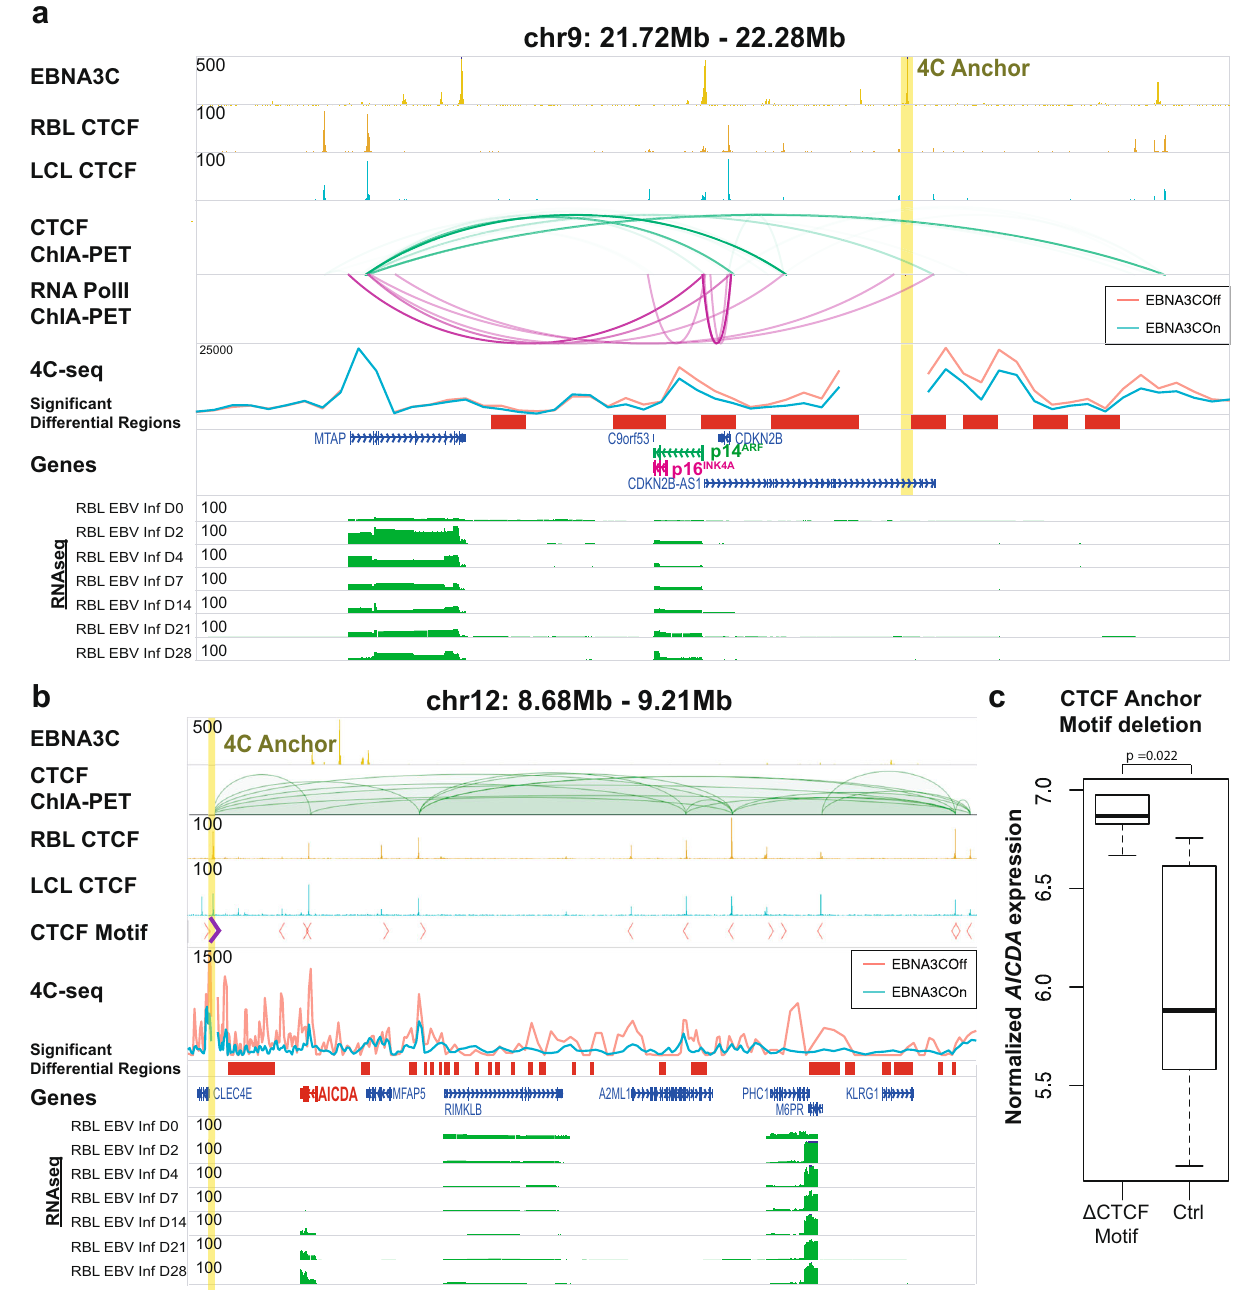
Fig. 7 | EBNA3C alters loopings at CDKN2A/B and AICDA. a Chromatin interac- tions at the CDKN2A/B locus is shown, with the 4C-seq anchor shown at a distal EBNA3C peak residing upstream of the p14 ARF and p16 INK4A promoters. Signi fi cant differentialregions( p <0.05)areshowninredbars,whichoverlapwithanumberof regions previously identi fi ed by CTCF and POL2RA ChIA-PET. EBNA3C inactivation (EBNA3C Off) resulted in increased chromatin interactions of regions upstream of p14 ARF and p16 INK4A with its promoters, indicating putative regulatory regions that are suppressed by EBNA3C to downregulate p14 ARF and p16 INK4A . b Chromatin interactionsattheAICDAlocusisshown,withthe4C-seqanchoratakeyCTCFsite involved in multiple interactions at this locus. Signi fi cant differential regions